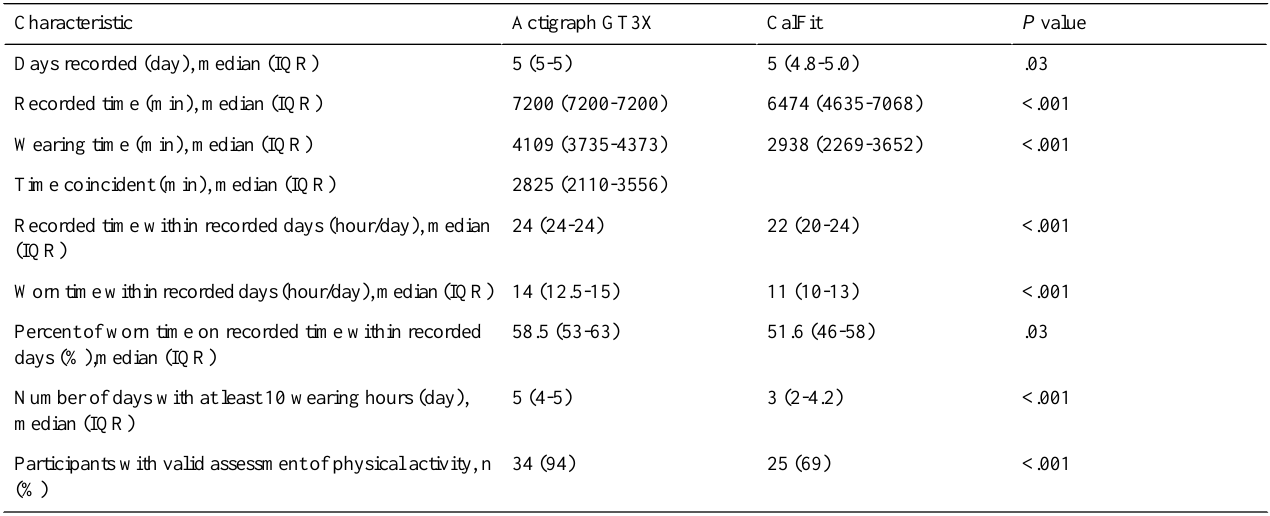
Table 3. Comparison of usability characteristics between Actigraph and CalFit.